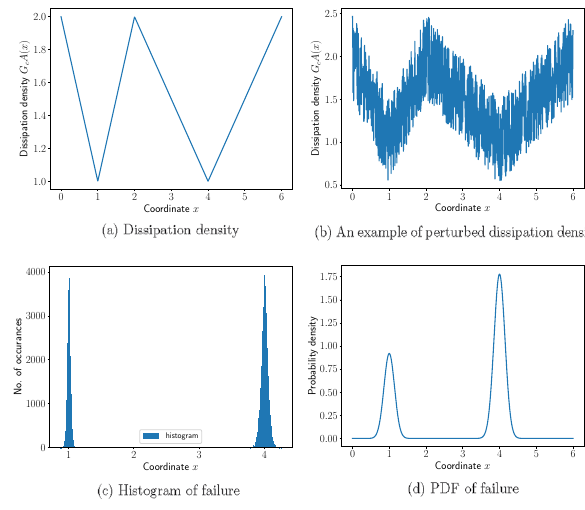
Fig. 29 Bar with linearly varying fracture energy